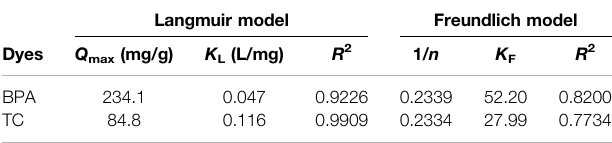
TABLE 2 | Parameters of pseudo- fi rst-order, pseudo-second-order, and intraparticle diffusion models. Kinetics